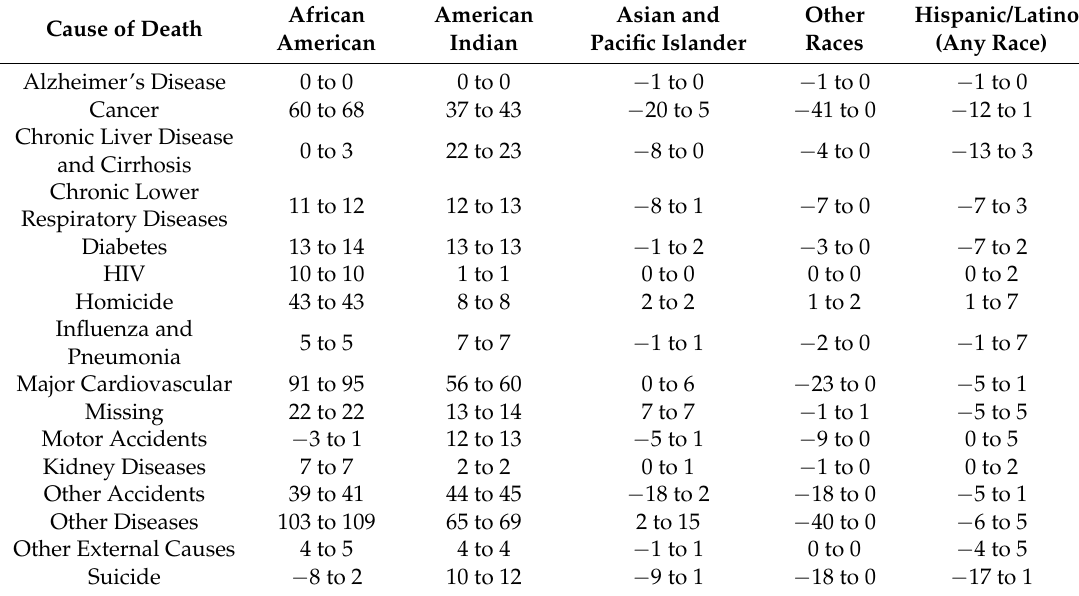
Table 2. Annualized potential lives saved among minorities by cause of death.